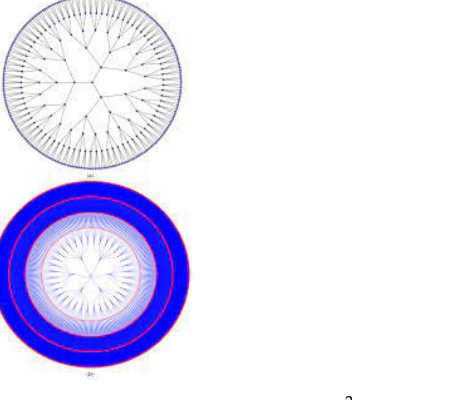
Figure 2. A 5-level pandemic tree Ω 3